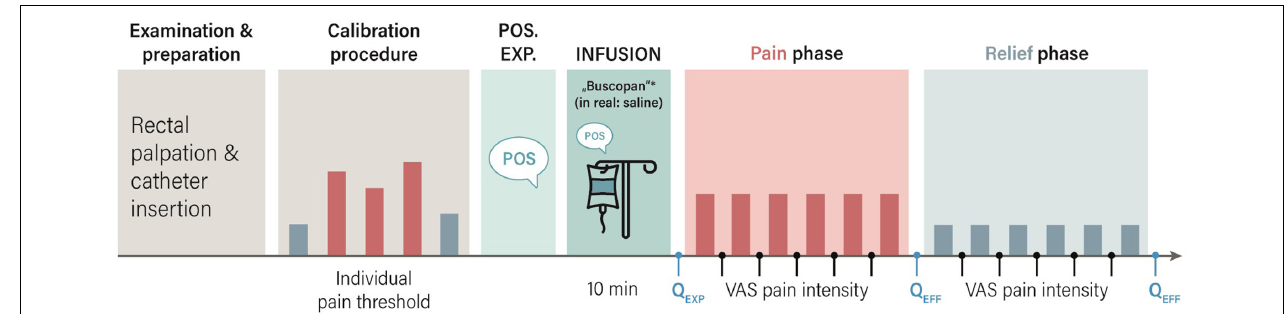
FIGURE 1 | Study procedures for the placebo group. After rectal catheter placement, individual pain thresholds were determined in a calibration procedure. The study physician verbally delivered treatment suggestions about treatment with a spasmolytic drug (in reality saline) in order to induce positive treatment expectations (Pos. Exp.), and the intravenous infusion was started. In the subsequent pain phase, individual distension pressures inducing pain were applied. In the pain relief phase, pressures were surreptitiously reduced to model pain relief. Using visual analog scales (VAS), expected ( Q EXP ), and perceived ( Q EFF ) treatment efficacy were assessed. Perceived distension intensity was assessed after each stimulus, and averaged for the pain and pain relief phases, respectively. *Buscopan: scopolamine butylbromide.